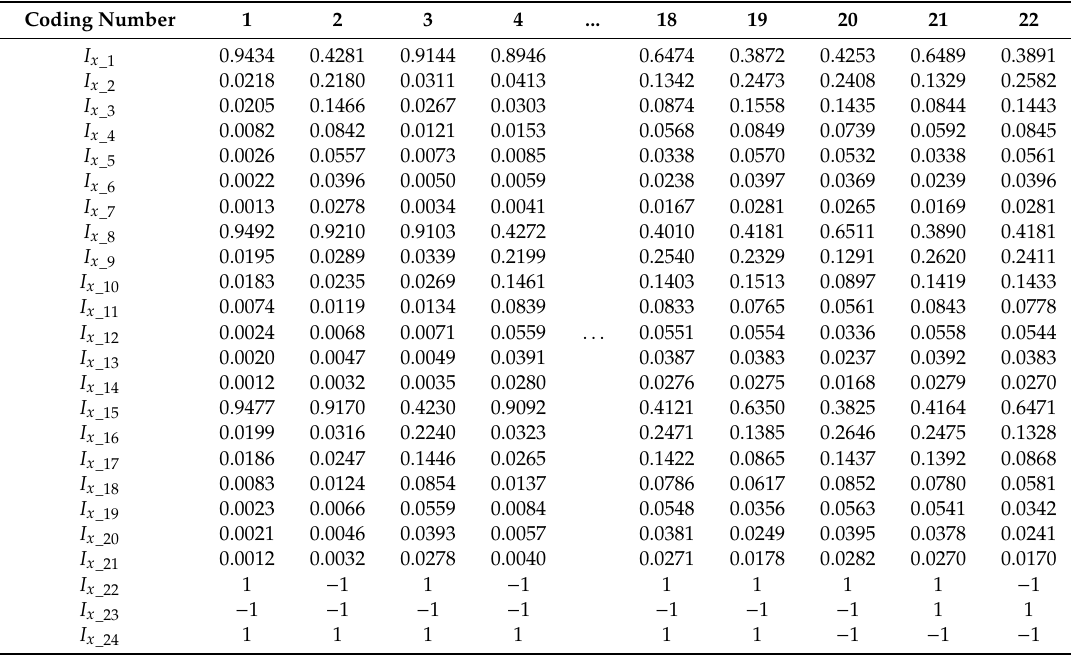
Table 7. The trend feature vectors under 22 states of GSC.